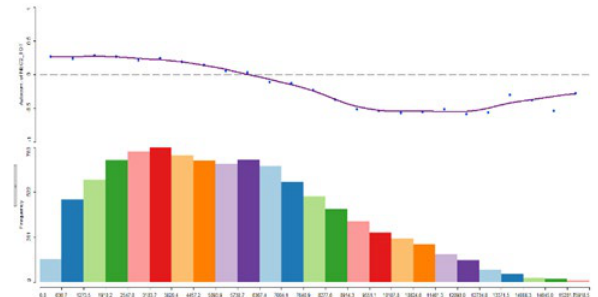
Figure 4. Correlogram indicating spatial process at work over varying spatial lags